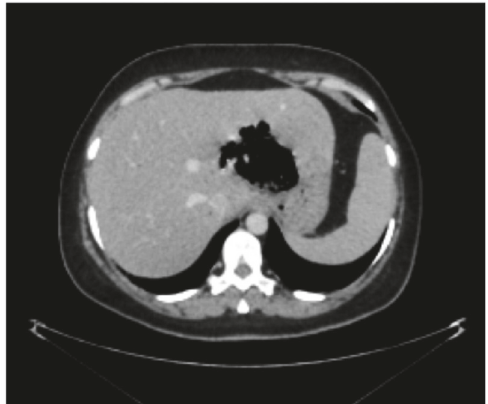
Figure1:AxialabdominalCTscanwithoralandIVcontrast.Mixed collectioncontaining airand debris spreading attheposterioraspect of the left lobe of the liver mainly in segments II and III, limited laterally by the left portal vein and extending medially towered the lesser curvature of the stomach associated with moderate intra- and extrahepatic biliary dilation. Sharply marginated left borders are